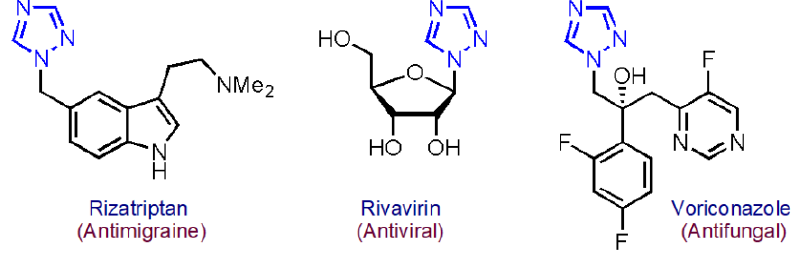
Figure 1. Representative bioactive molecules containing 1,2,4-triazole structural motif.